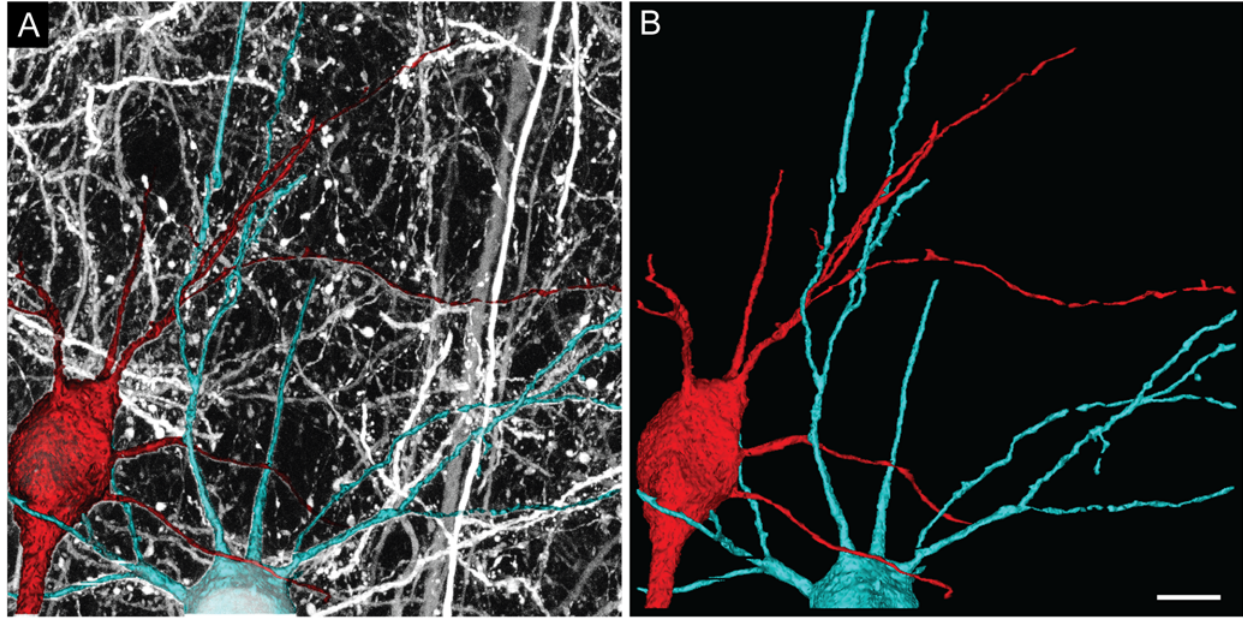
Figure 5. Reconstruction of dendrites of cortical pyramidal neurons. A . Dendrites of two pyramidal neurons were reconstructed together with part of the cell bodies from an image stack that contained many en passant neural processes. Reconstructed neurons were superimposed on the maximum-intensity projection of the entire image stack. B . 3D rendering of the two reconstructed neurons. Scale bar: 10 m m.